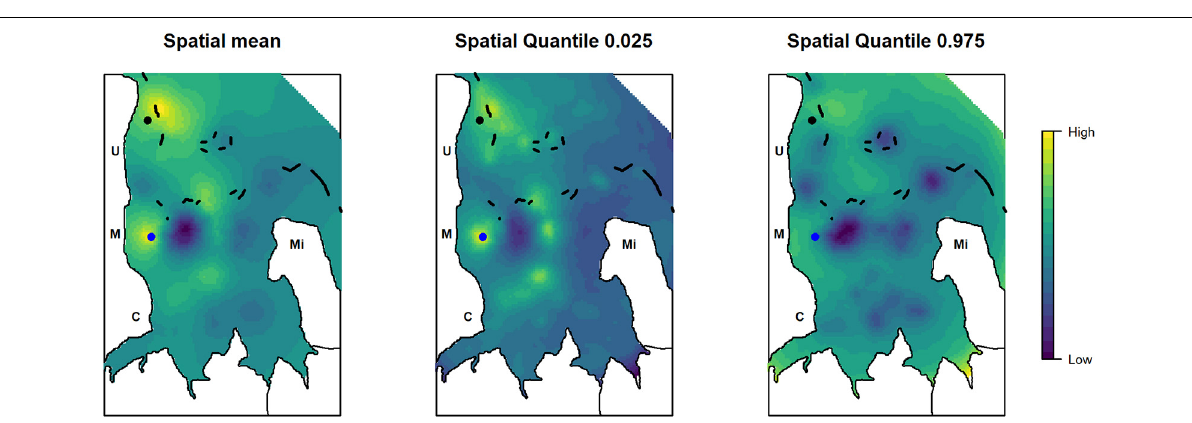
FIGURE 6 | Posterior distribution of the mean, first, and third quantile of the combined spatial effect of the analyzed species to identify areas of overlapping high relative abundance. The dots represent a dragnet free zone (blue) enforced by the Marumbi fishers and the area proposed for the implementation of a no-take zone during the participatory workshop in 2016 (black). Letters indicate the position of the villages: C, Chwaka; M, Marumbi; U, Uroa; Mi, Michamvi. Black lines depict the